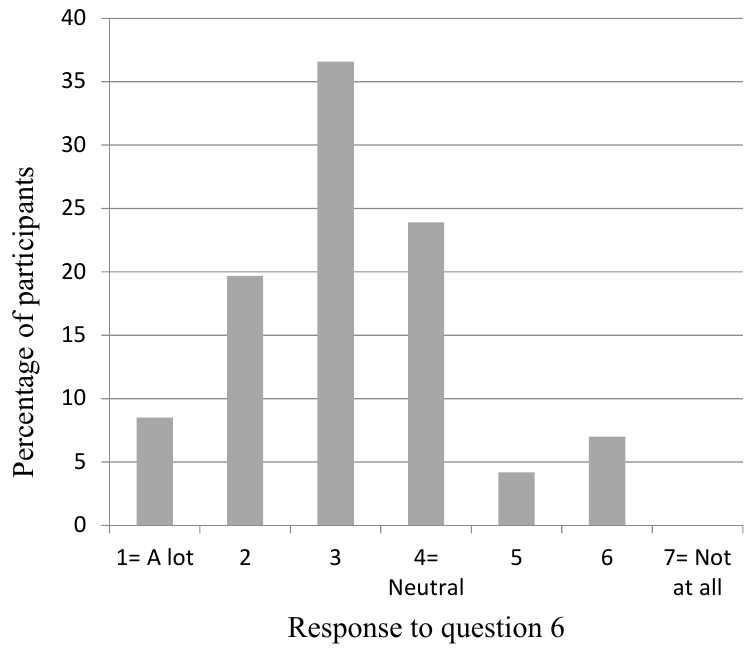
Figure 5. Participants’ response to Question 6: “How much do your own personal values (beliefs, priorities & preferences) influence your presentation of material to patients who are in the process of choosing among different treatment options?”